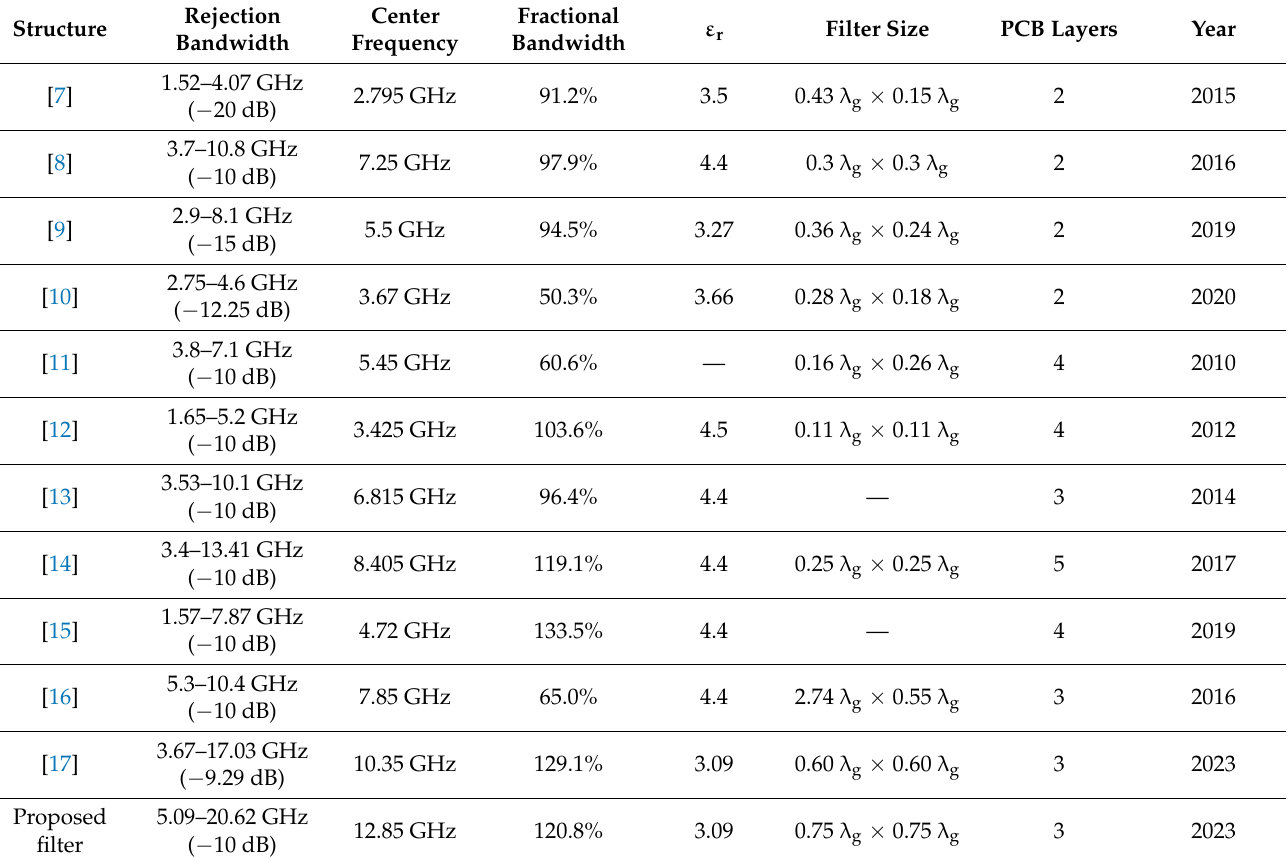
Table 3. Comparison of the performance of different CM noise suppression